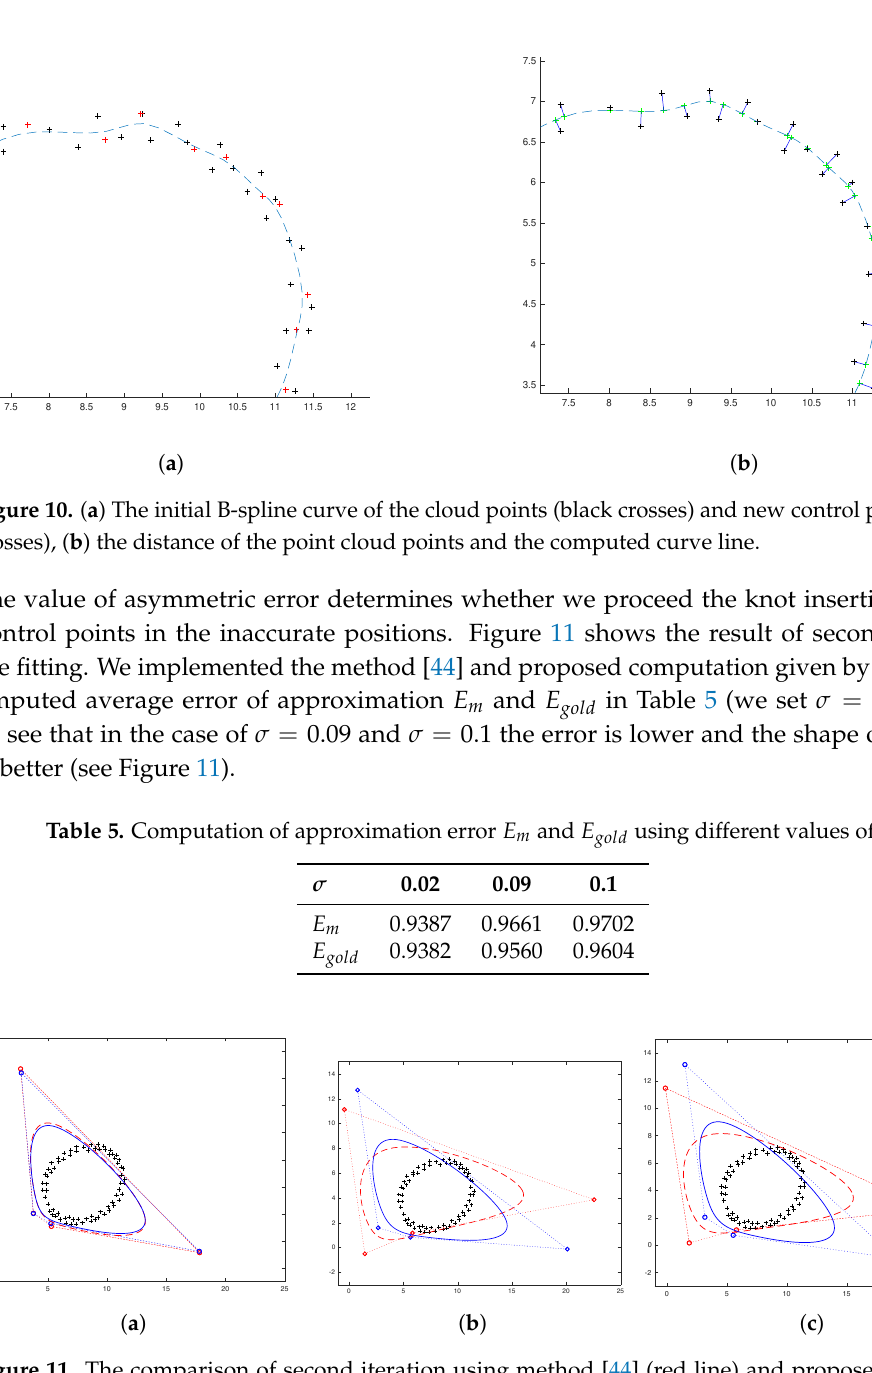
Figure 11. The comparison of second iteration using method [44] (red line) and proposed method given by Equation (22) (blue line). Different values of σ : ( a ) σ = 0.02, ( b ) σ = 0.09, ( c ) σ =